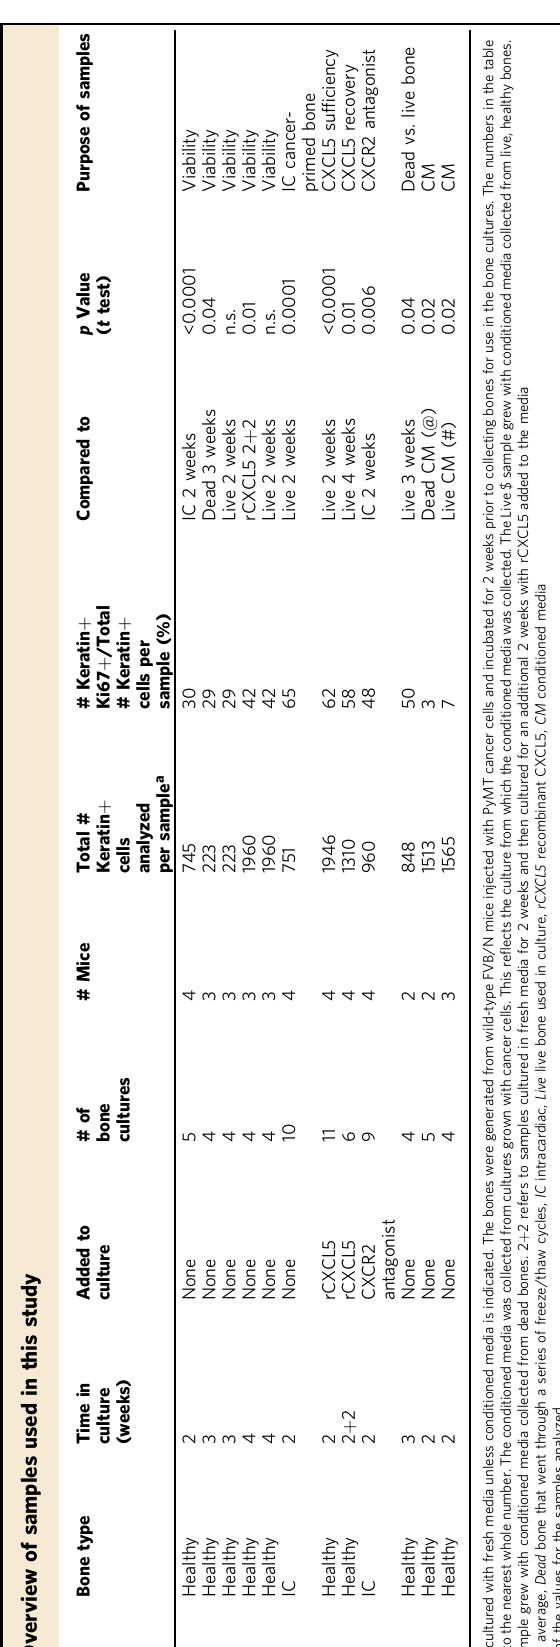
(22 nM) and on previously determined inhibition of CXCR2 activity at 100 nM 61 . IC injections . On the day of injection, cancer cells were trypsinized, collected, and resuspended at 1×10 6 cellsmL − 1 in ice-cold phosphate-buffered saline (PBS; without calcium or magnesium). After the mouse was anesthetized, it was in the supine position and the abdominal hair was removed with an electric razor followed by cleaning the shaved area with an alcohol swab. Using a 27-gauge needle, we injected 100 μ L of the cancer cell suspension (1×10 5 cancer cells per animal) into the left cardiac ventricle of the mouse (8 – 10-week-old FVB/N mice). The mouse then recovered on a heating pad 75 . Following IC injection of cancer cells, mice were maintained under pathogen-free conditions. Two weeks postinjection, the mice were sacri fi ced. We then extracted their femurs and tibiae and maintained them in culture as described above. At this time point, the IC-injected mice began to look unhealthy and/or in pain. Per University policy and humane treatment of the animal subjects for research, the animals were sacri fi ced to avoid suffering. Upon examining the mice, we observed tumors in the thoracic cavity of some of the animals. T